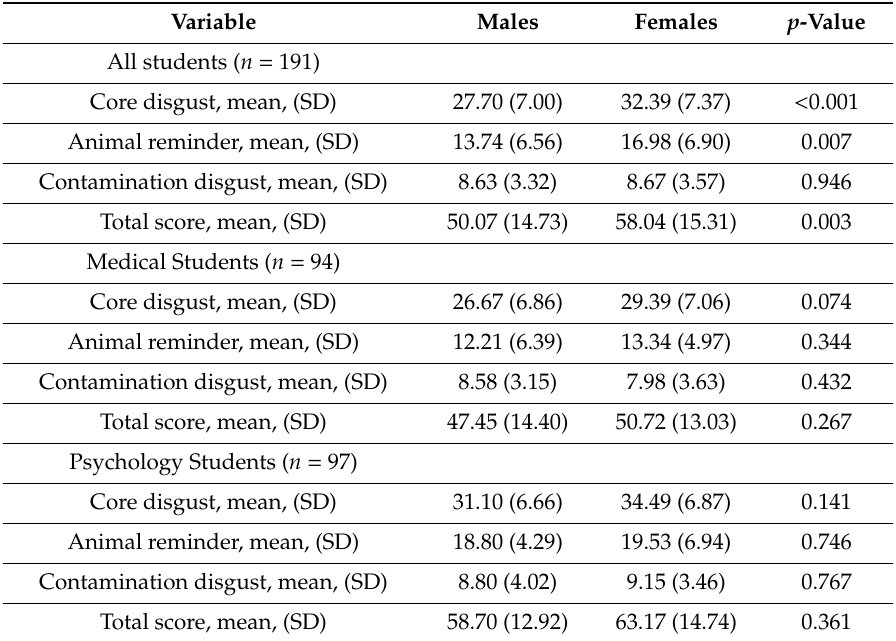
Table 4. Score distribution according to